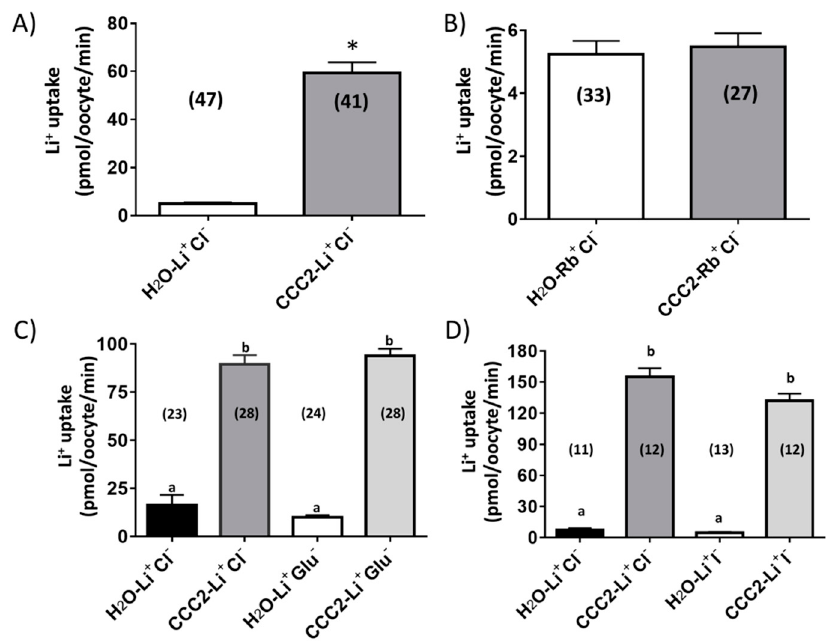
Figure 2. Rates of Li + ( A ) and Rb + ( B ) uptake measured in Xenopus oocytes three days after injection of aeCCC2 cRNA (80 ng) or nuclease-free H 2 O (80 nL). The * represents a significant difference using a Student’s t -test ( p < 0.05). Effects of substituting extracellular Cl − with gluconate ( C ) or iodide ( D ) on Li + uptake rates in aeCCC2 or H 2 O-injected oocytes. The lowercase letters indicate statistical categorization of the means as determined by an ANOVA with a Tukey post-test ( p < 0.05 ). In all panels, values are means ± SEM based on the number of oocytes in parentheses.